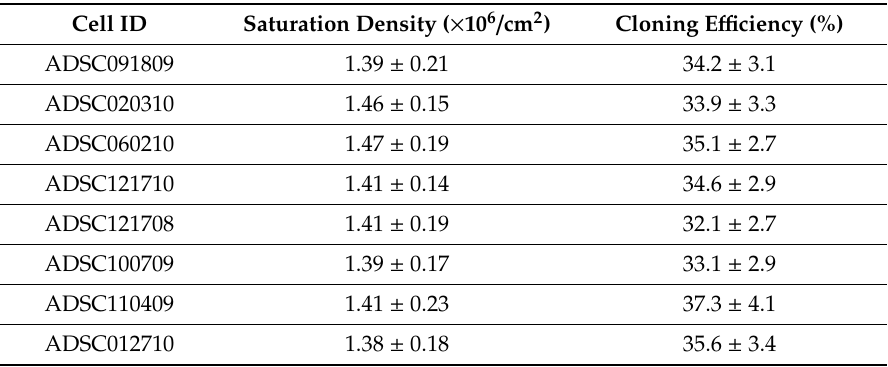
Figure 1. Morphology of adipose-derived stem / progenitor cells (ADSCs) cultures at passage 1 obtained from human immunodeficiency virus (HIV)-infected and HIV-unrelated patients. Exponentially growing ADSCs were cultured in serum free-medium in type I collage-coated flasks. Magnification × 100; the scale bar indicates 100 µ m. Table 2. Biological properties of